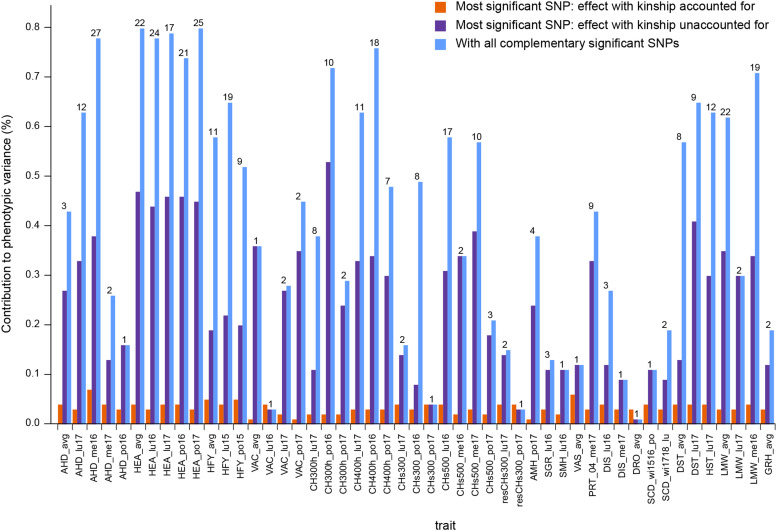
Contribution to phenotypic variance of the most significant SNPs detected by GWAS (which accounted for kinship) computed using either a model that accounted for kinship (red bars) or a model which did not account for kinship (green bars). The contribution to phenotypic variance of all complementary significant SNP detected by GWAS (q-value <10%) is also displayed (blue bars). The information is only given for traits for which a least one significant SNP was detected by GWAS (q-value < 10%). The numeric values above the blue bars indicate how many complementary SNP (each significantly improve the multiple regression model) were detected for the given trait.